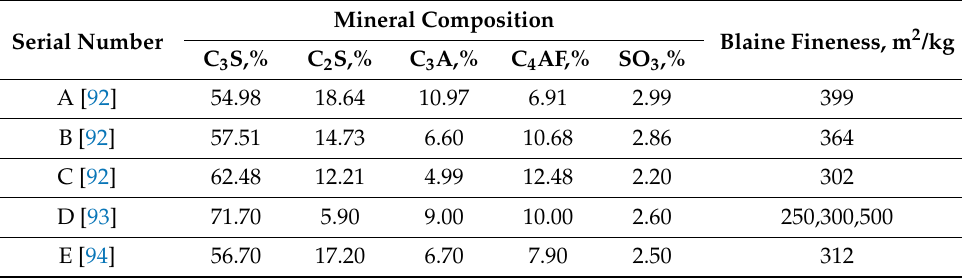
Table 2. Mineral compositions of